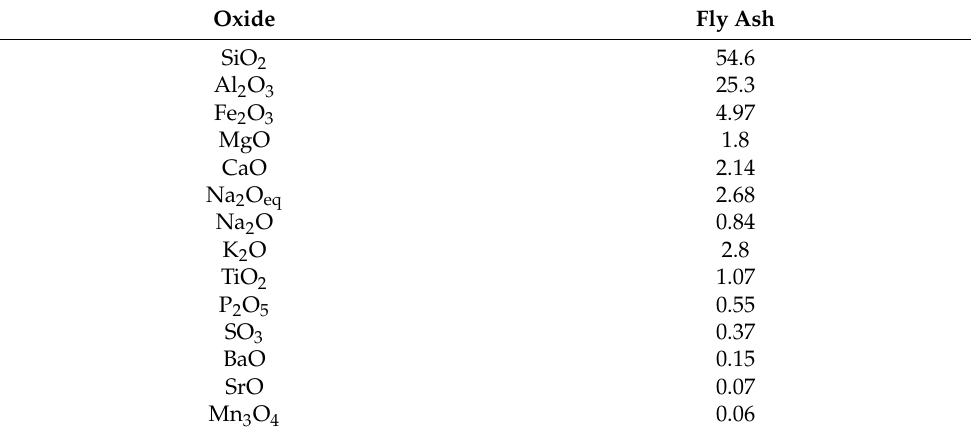
Table 1. Chemical oxide composition of fly ash (%).